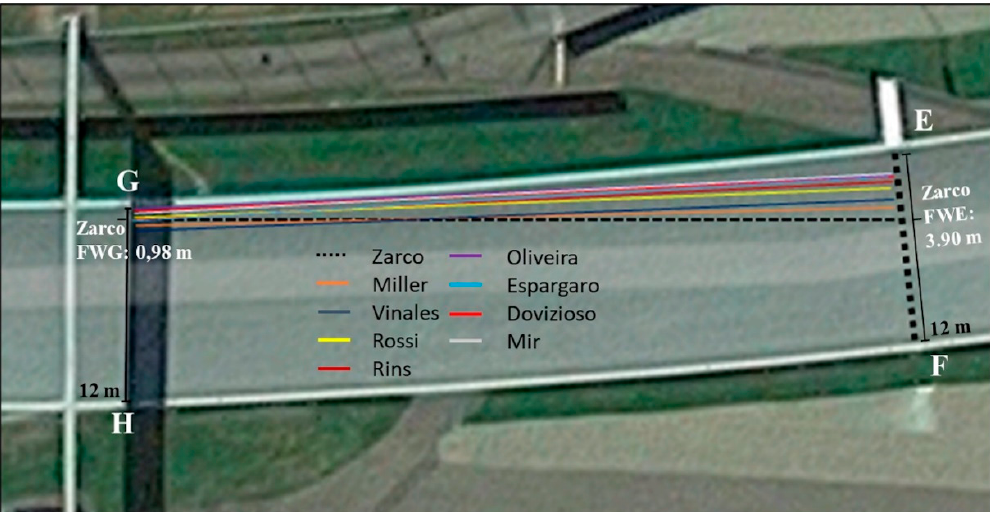
Figure 6. Distance between point G and point H: 12 m; distance between point E and point F: 12 m. The colored lines represent the trajectories of the first nine riders traced from point A, where the front wheels of the bikes cross the line between G and H, and point B, where they cross the line between E and F. We also reported the distance between Zarco’s Front Wheel and point G (FWG) and between his Front Wheel and point E (FWE): FWG: 0.98 m; FWE: 3.90 m.